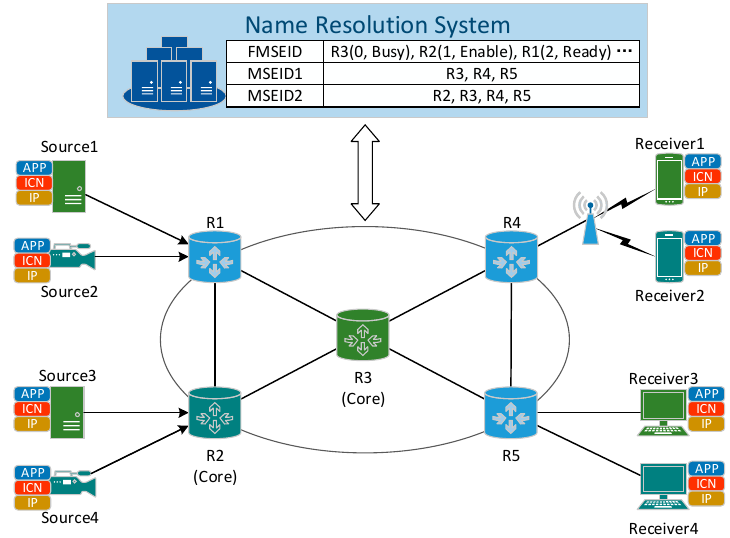
Figure 1. The architecture model of the ILDM.